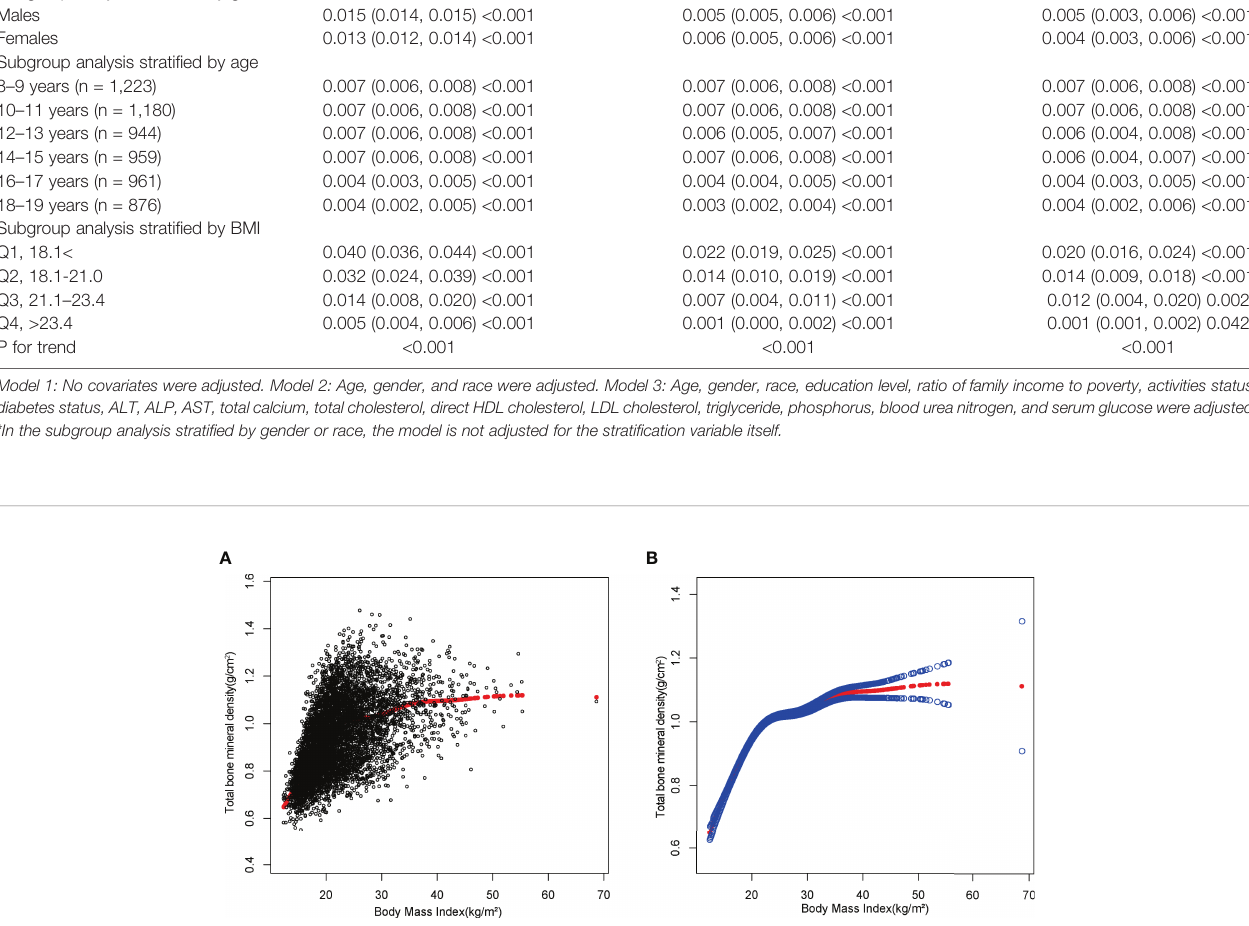
FIGURE 3 | The association between BMI and total bone mineral density. (A) Each black point represents a sample. (B) The solid red line represents the smooth curve fi t between variables. Blue bands represent the 95% con fi dence interval from the fi